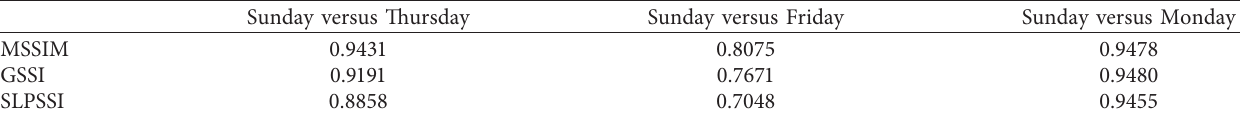
Table 7: Comparison of the GSSI, MSSIM, and SLPSSI methods on a sparse matrix at AL 1. Sunday versus Thursday